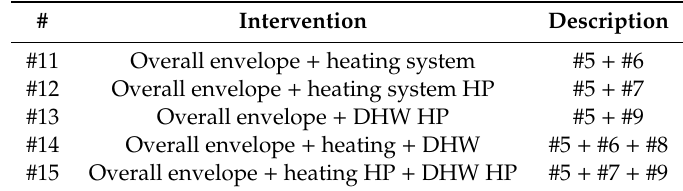
Table 3. Combination of building envelope retrofitting and system